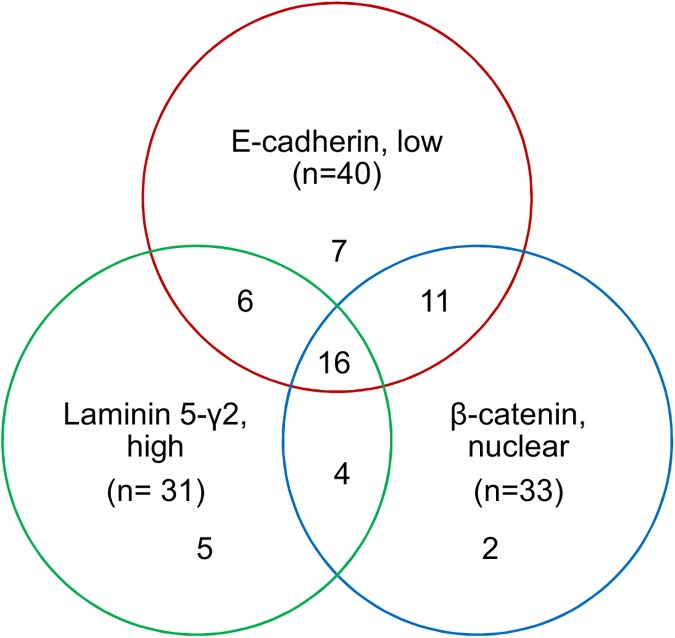
EMT-protein distribution in tumor center and at the invasive front.Venn diagram of colon cancers with tumor budding showing differentially expressed E-cadherin, nuclear β-catenin, and laminin-5γ2 in the invasive front compared to the tumor center. Out of 58 cases, a total of 51 cancers showed changes in at least one marker.